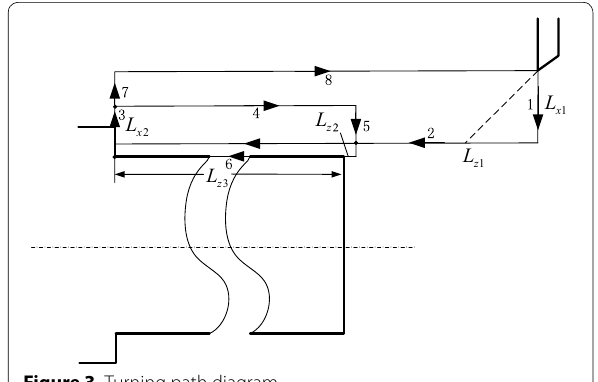
Figure 3 Turning path